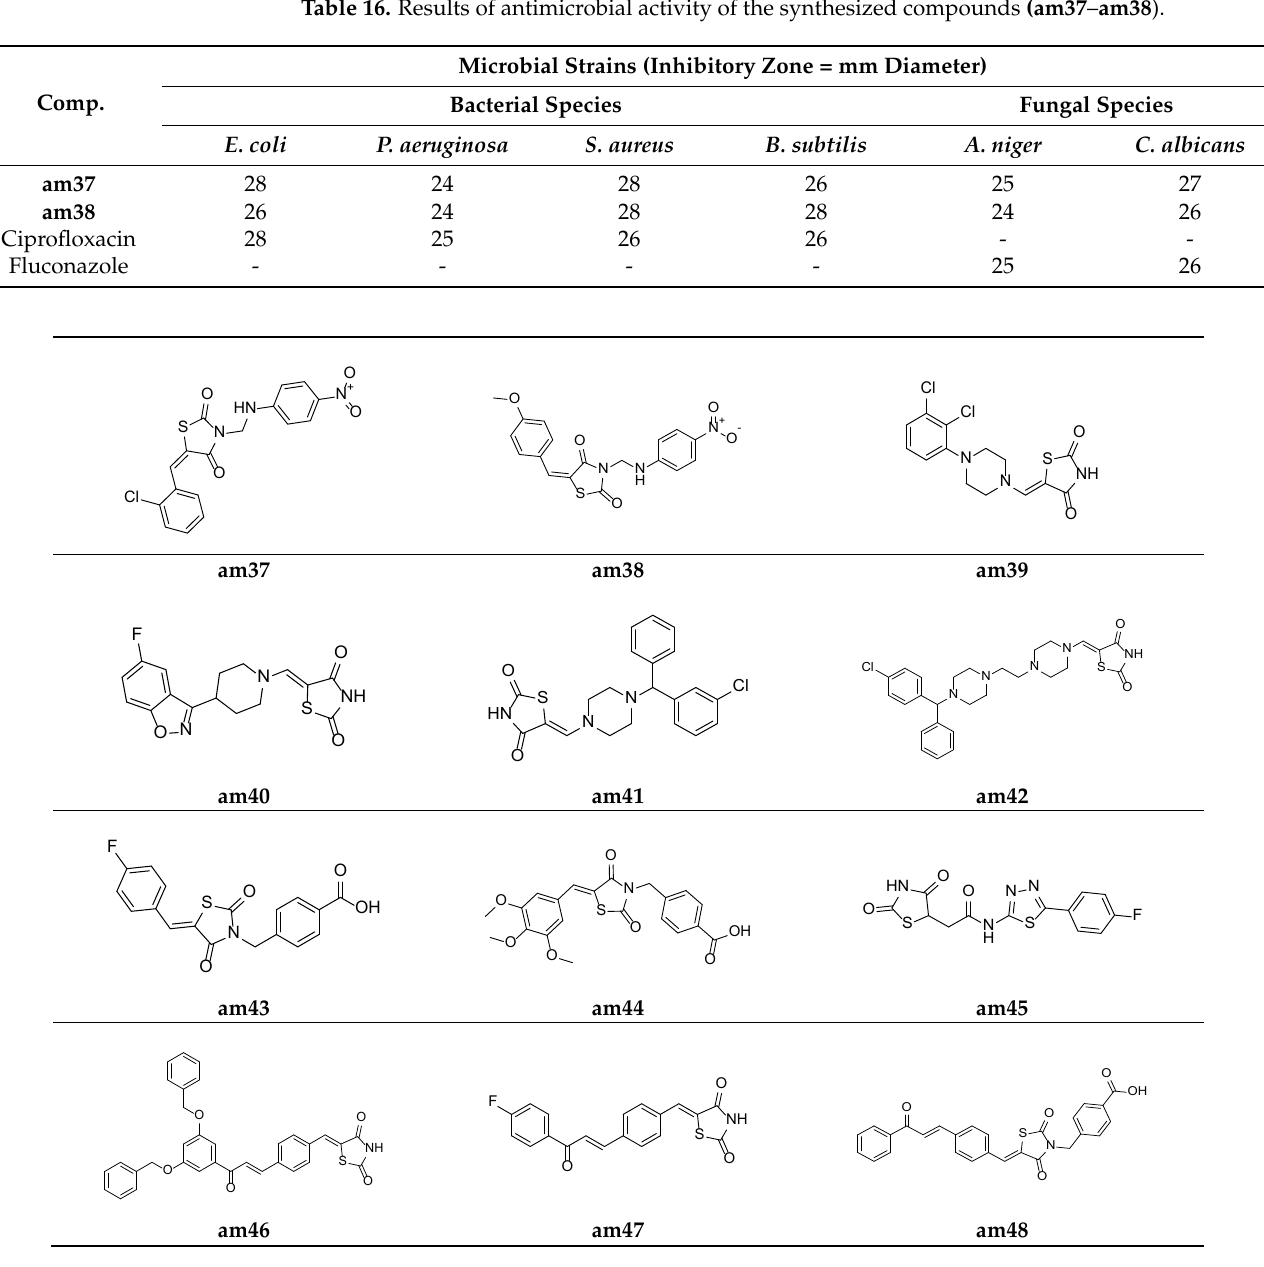
Figure 12. Molecular structures of the compounds ( am37 – am48 ). A series of substituted 5-(aminomethylene)thiazolidine-2,4-diones derivatives w active pharmacophores were derived by Mohanty et al. and tested for their in vitro antimicrobial potential against different strains of bacteria and fungi using the two-fold serial dilution method and poisoned food method, respectively. Compounds am39 and am40 showed a moderate antibacterial activity, while the compounds am39 , am40 , am41, and am42 showed a promising antifungal activity compared to the standard drugs, ciprofloxacin and fluconazole respectively (Table 17, Figure 12) [22]. Table 17. Results of antimicrobial screening of the synthesized compounds (am39 – am42). Comp.